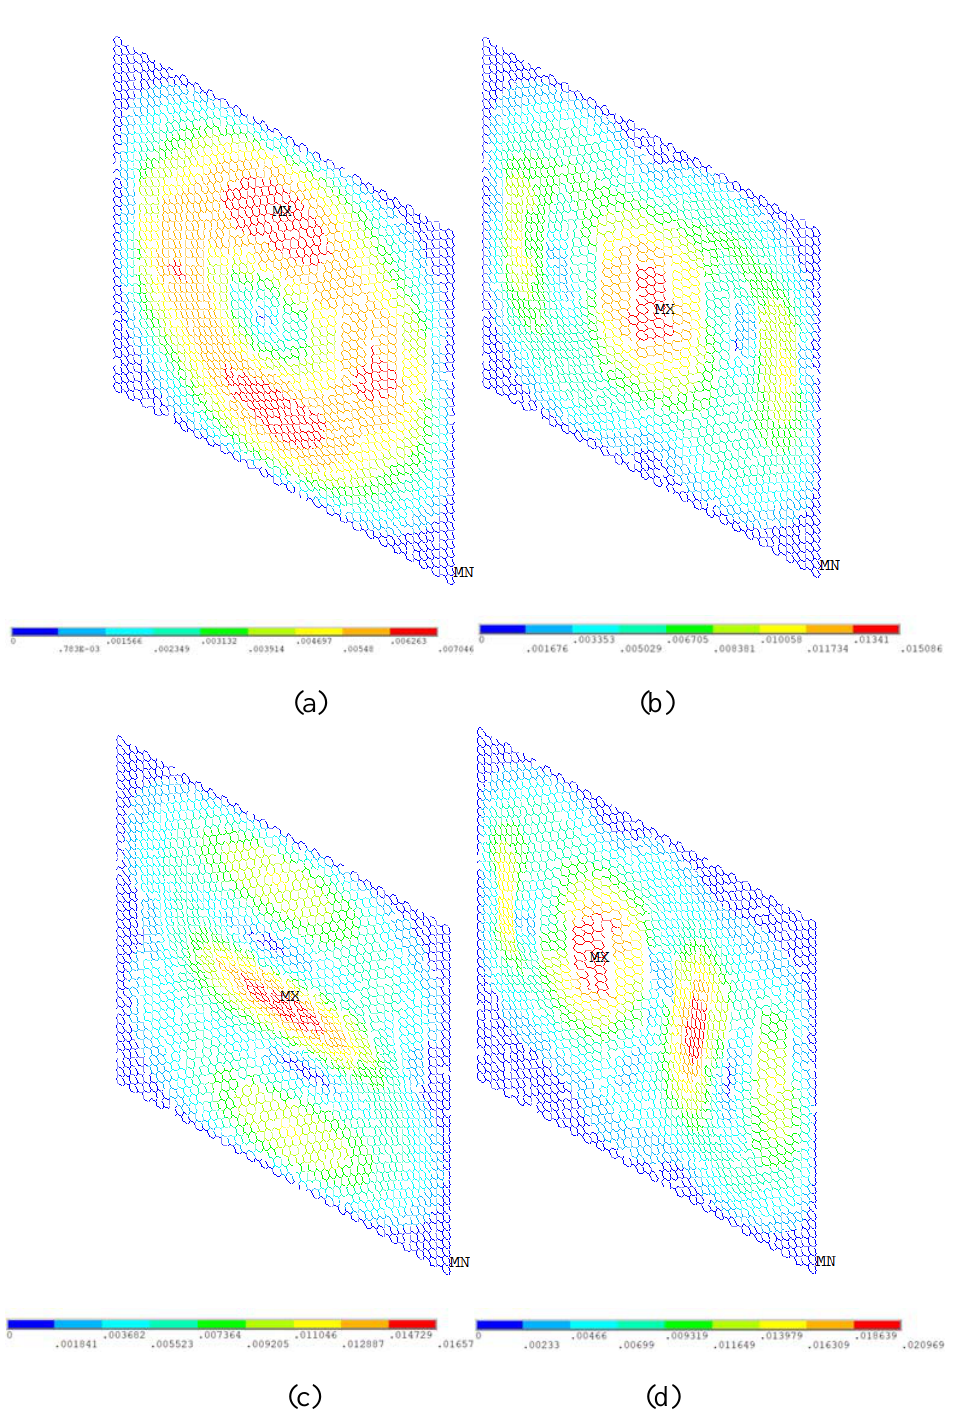
Figure 12. Rotation vector sum for graphene with 5% vacancy defects ( a – d represent the first order, second order, third order, and fourth order of vibration mode, respectively).